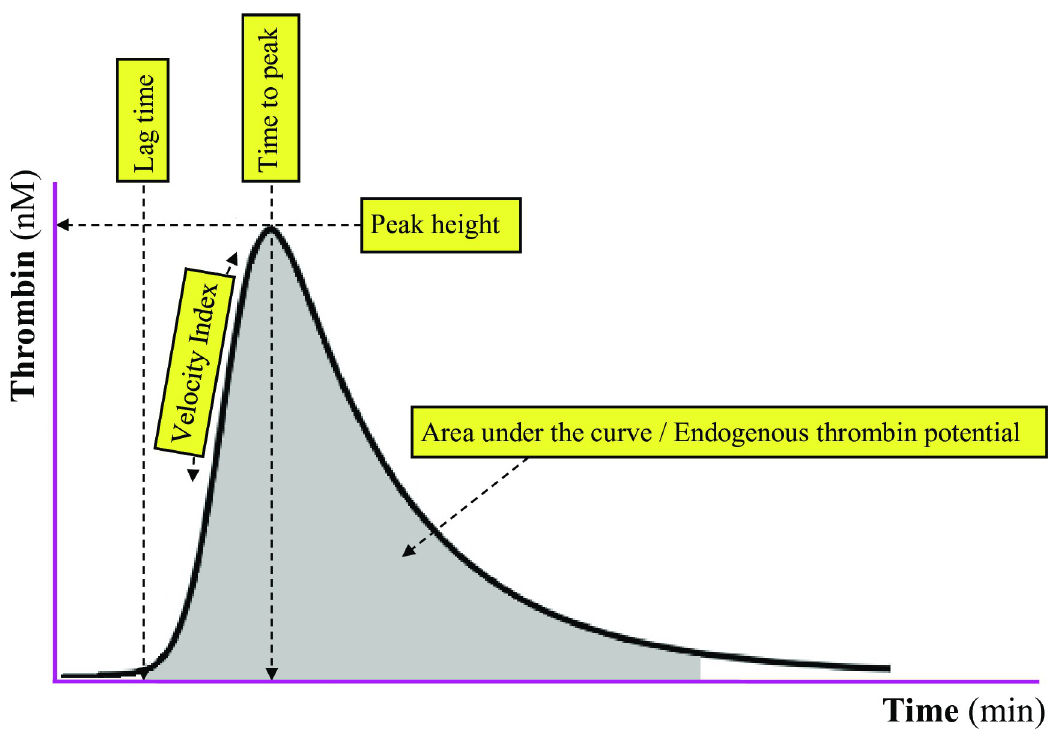
Fig 1. Overview of thrombin generation